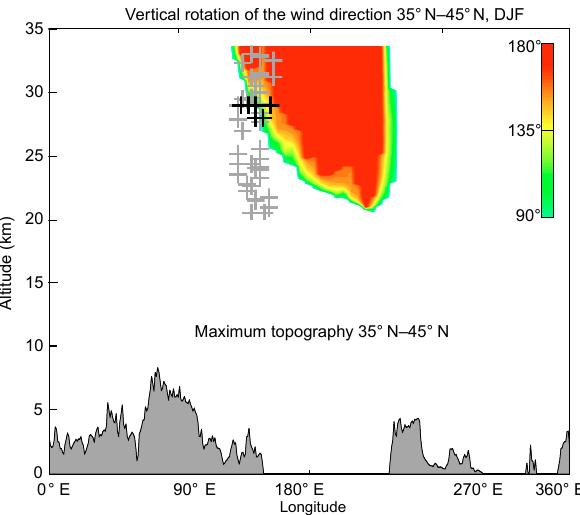
Figure 6. Vertical profile of the wind direction rotation between the surface and 7hPa for the DJF season and 35 ◦ –45 ◦ N latitudinal belt (top) and related maximum topography (bottom). The color scale represents degrees of the rotation. The crosses represent the height of maximum σ 2 values (black represents the profile means; grey represents individual